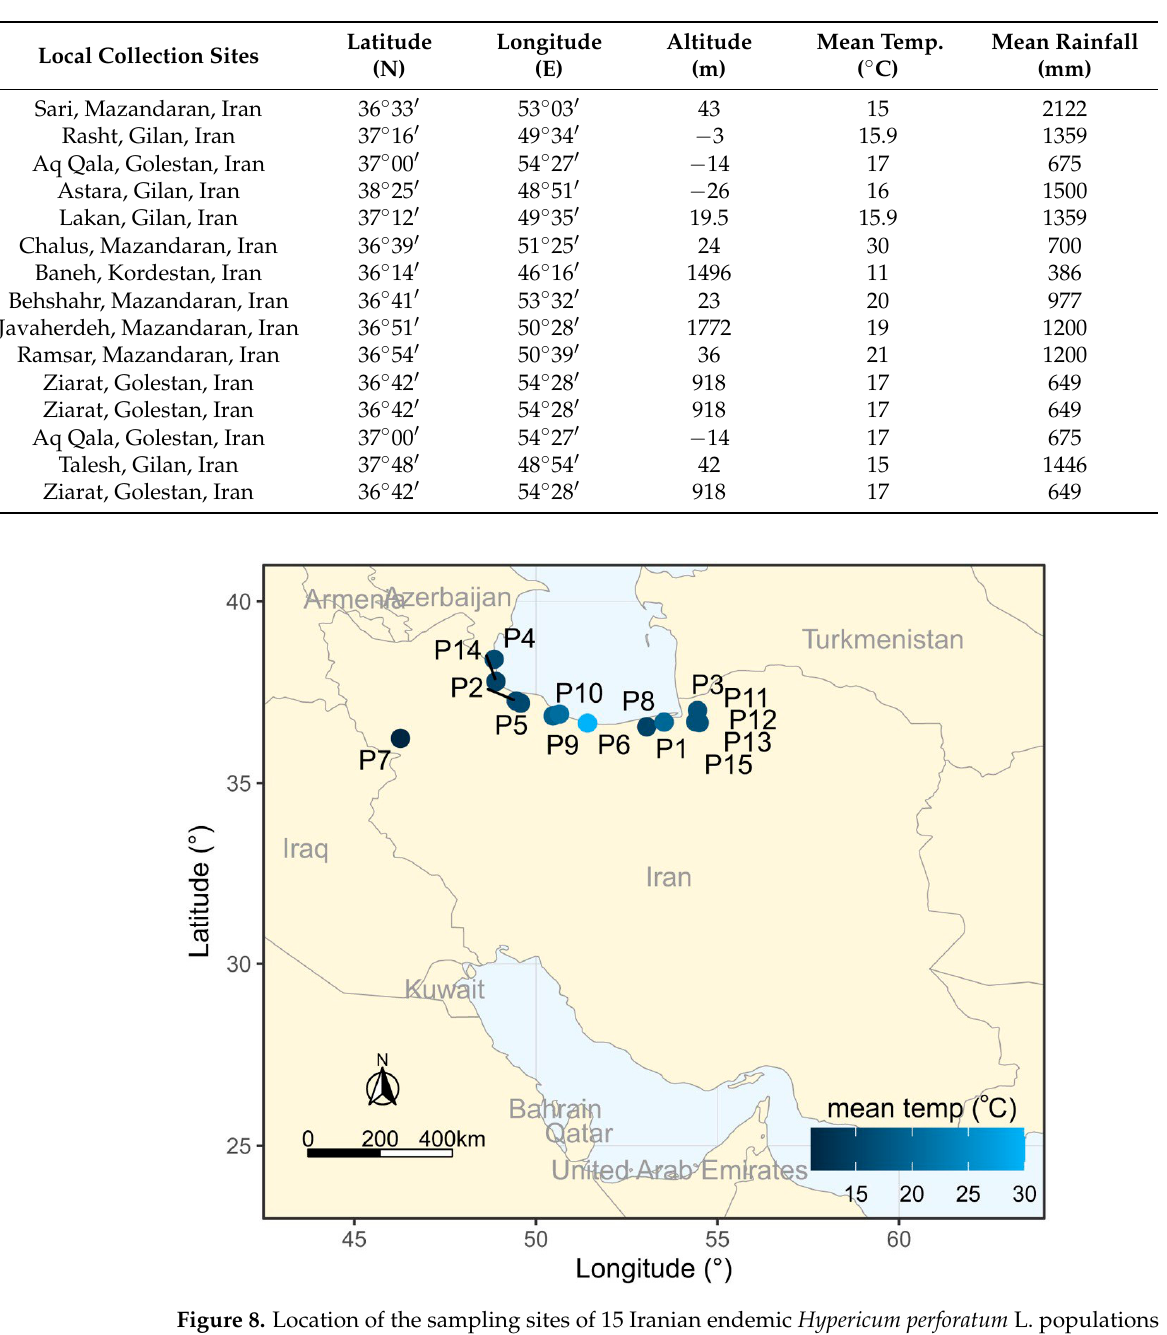
Table 3. Geographical description of Iranian endemic Hypericum perforatum populations.